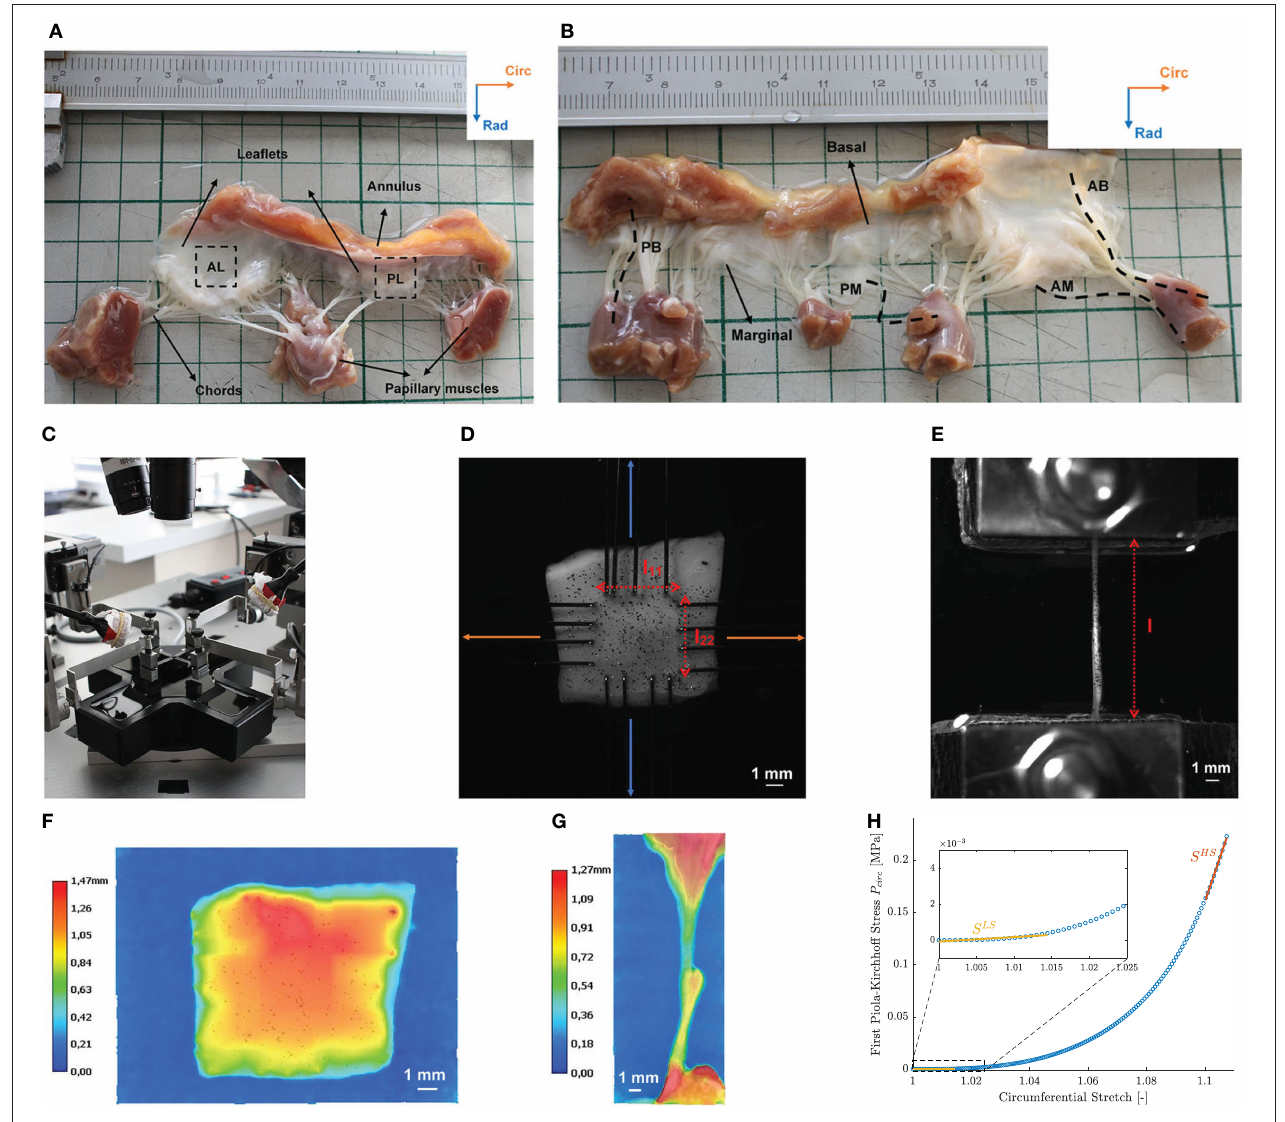
FIGURE 1 | Overview of the different steps in the mechanical experiments on human mitral valves. (A) Square samples were excised from the anterior (AL) and posterior (PL) leaflet of a human MV with the edges aligned to the circumferential and radial direction. (B) Four types of chord samples were tested: anterior basal (AB), anterior marginal (AM), posterior basal (PB), and posterior marginal (PM) chords. (C) ZwickRoell planar biaxial tester used for the experiments. Samples were immersed in saline at a temperature of 37 ◦ C . (D) Leaflet samples were mounted in the device with the edges aligned to the circumferential and radial directions using rakes. l 11 and l 22 represent the distance between the opposing rakes in the circumferential and radial direction, respectively. (E) Mounted chord sample. Clamps were lined with sandpaper to prevent slipping of the samples. The distance between the clamps is indicated by l . (F) Thickness map of a leaflet sample obtained by 3D image stitching. (G) Diameter distribution of a chord sample obtained by 3D image stitching. Data of the annulus and papillary muscle were removed in the diameter analysis. (H) Linearized stiffness moduli were calculated as slope of the first Piola-Kirchhoff model stress at both low (LS) and high (HS) stress for each